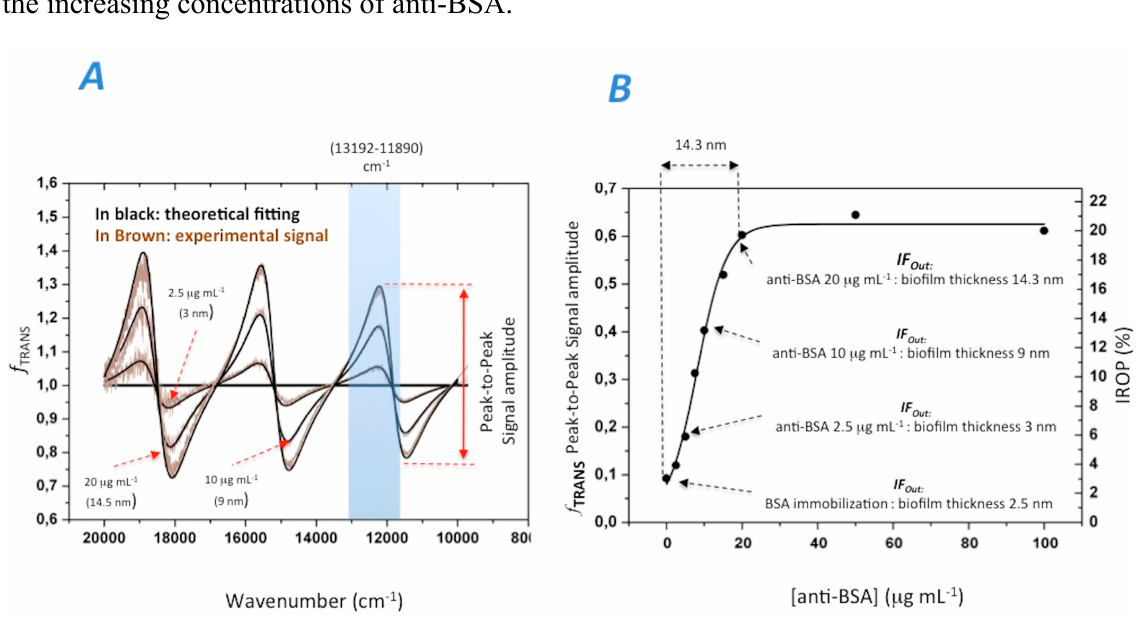
Figure 4. Experimental response for measuring BSA / Anti-BSA immunoassay: ( A ) f